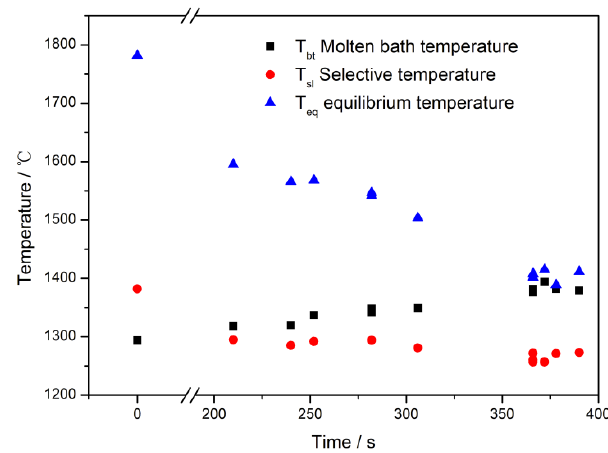
Figure 4. Variations on the molten bath temperature and T eq .